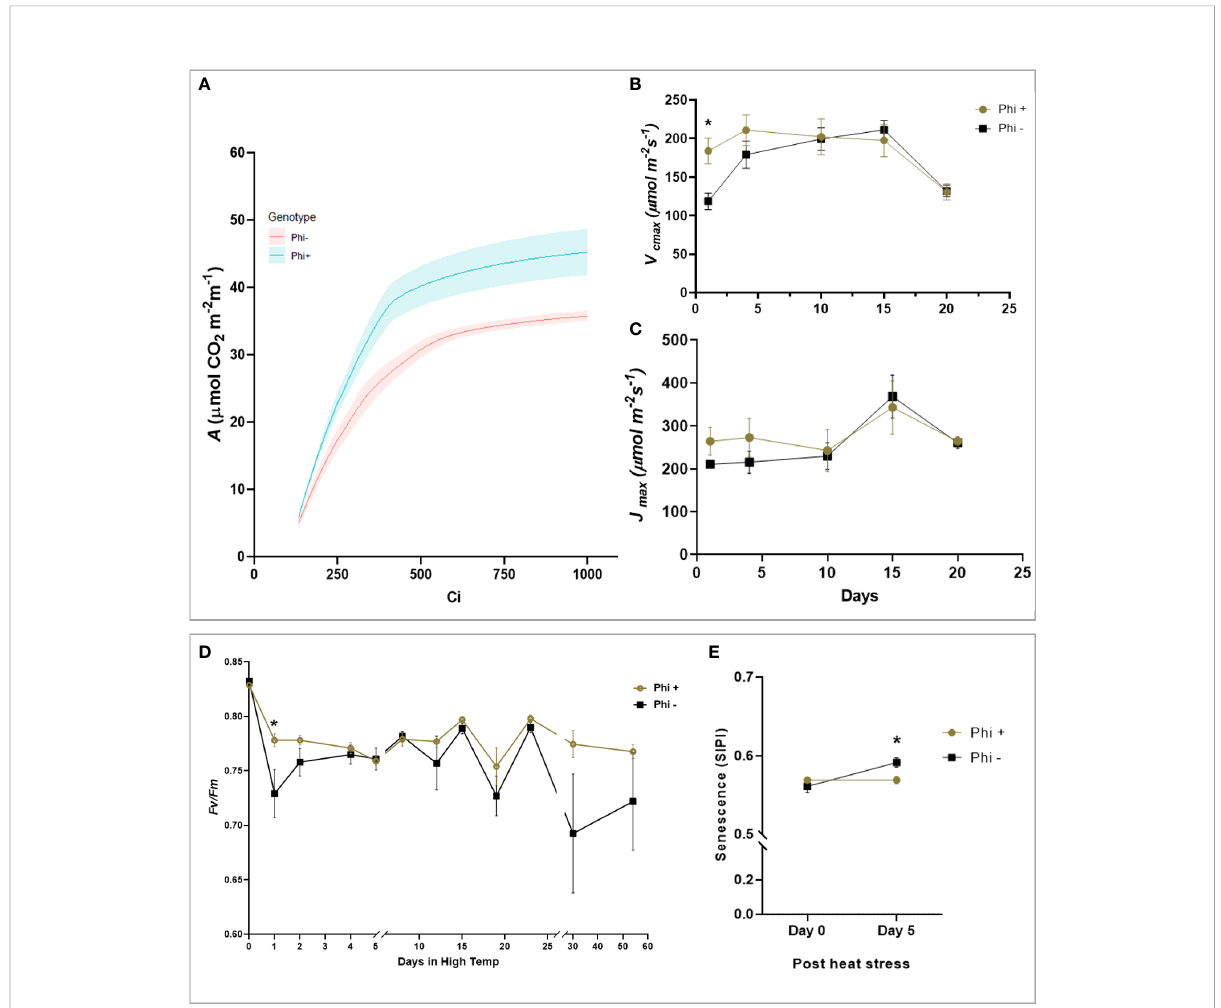
FIGURE 5 Phosphite treatment shows improve tolerance to heat treatment. (A) . A versus Ci response curve at 24hr of heat treatment. For visual clarity the lines are fi tted through mean values and the shaded region show limits to the standard error of mean. (B) . Maximum rate of carboxylation of Rubisco ( V cmax ) (C) . Maximum rate of RuBS regeneration/electron transport ( J max ) (D) . Maximum ef fi ciency of photosystem II after dark adaptation. (E) Canopy senescence (SIPI). All points are means ± SE (n= 5 - 10); (* represent signi fi cant differences between phosphite treated and untreated of the same time point (P ≤